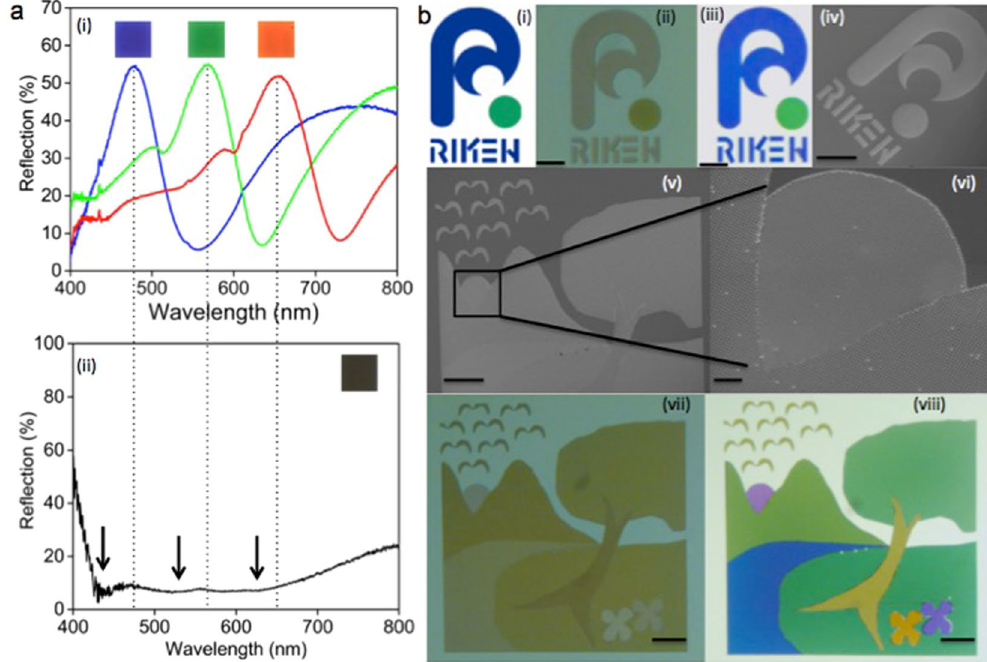
Figure 6. Full colour image printing and spectra of prominent colours red, green, blue and black. ( a ) Experimental reflection spectra for the (i) blue, green, red and (ii) black colour pallets. The black colour pallet is optimized using a broadband plasmonic light absorber consisting of metal structures of different sizes and the arrows in (ii) indicate the positions of resonant dips of individual plasmonic elements. The positions of peak reflections suppressed in (ii) is represented by the dotted trace lines. ( b ) Sub millimeter scale RIKEN logo and an artwork are printed using our colour mapping scheme to demonstrate the up scalable full colour image printing with high colour saturation. (i) Original RIKEN logo, (ii) lithographically patterned RIKEN logo in 300 μ m square area before Al deposition, (iii) RIKEN logo after Al deposition and (iv) its SEM image. (v) SEM image of the art work printed in 300 μ m square area using EBL, (vi) enlarged SEM image of the sun area, (vii) optical micrograph before Al deposition and (viii) that after Al deposition. All colour images are captured using a bright field optical microscope with 10x objective of NA 0.25. Scale bars: 50 μ m (ii)–(v), (vii) and (viii) and 5 μ m